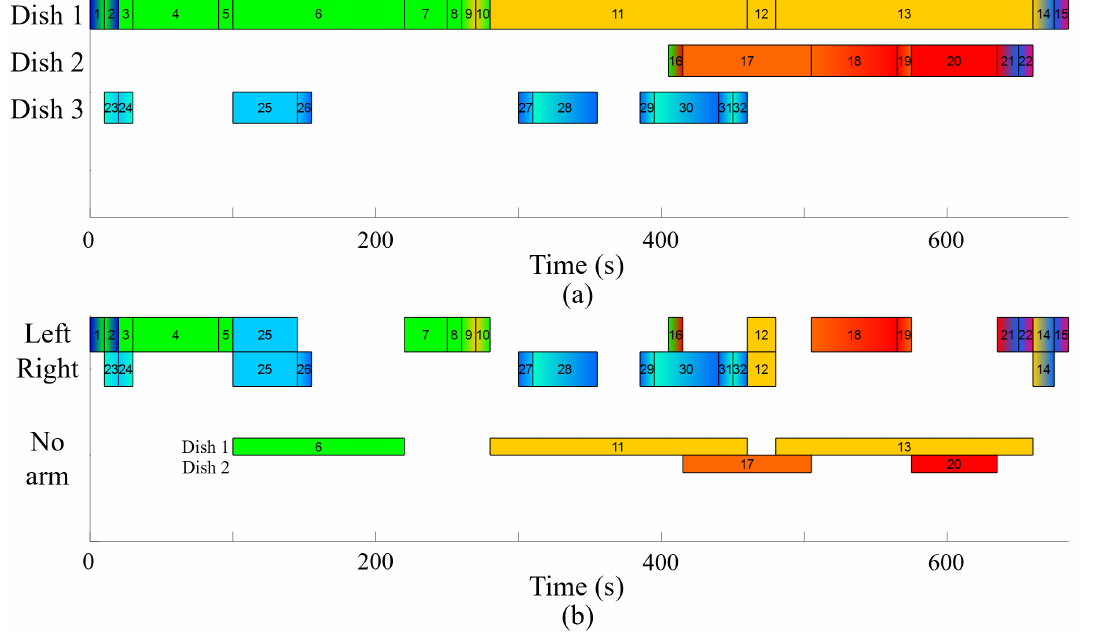
Figure 3. The optimization result of T in Table 1. It shows that makespan is minimized without any violation of the constraints. While the left arm made dish 1 mainly, the right arm made dishes 2 and 3. ( a ) The result of the first step of the optimization process. It shows the sequence of tasks per dish. ( b ) The result of the second step of the optimization process. It shows the sequence of tasks per each robot